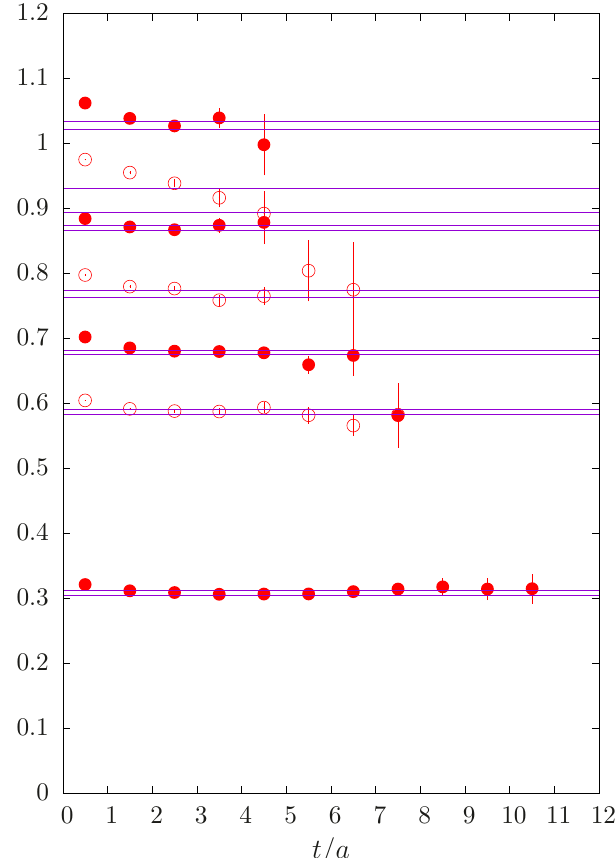
Figure 8 . E(cid:11)ective energies of the ground state traced string in SO(4) at (cid:12) = 15 : 1 for lengths l = 18 ; 30 ; 34 ; 38 ; 42 ; 46 ; 50 in order. Pairs of lines are